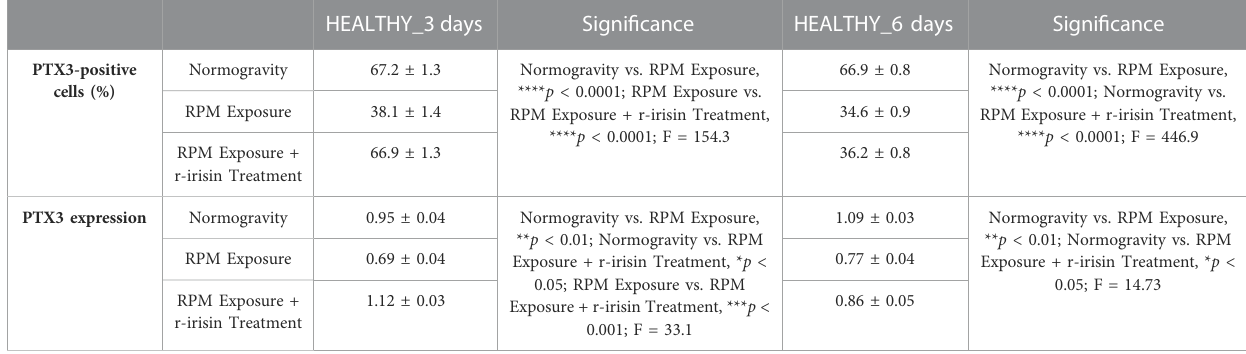
TABLE4Meanvalues±standarderrorandrelativesigni fi canceforthemineralizationprocessassessmentinHEALTHYsubjectsafter3and6